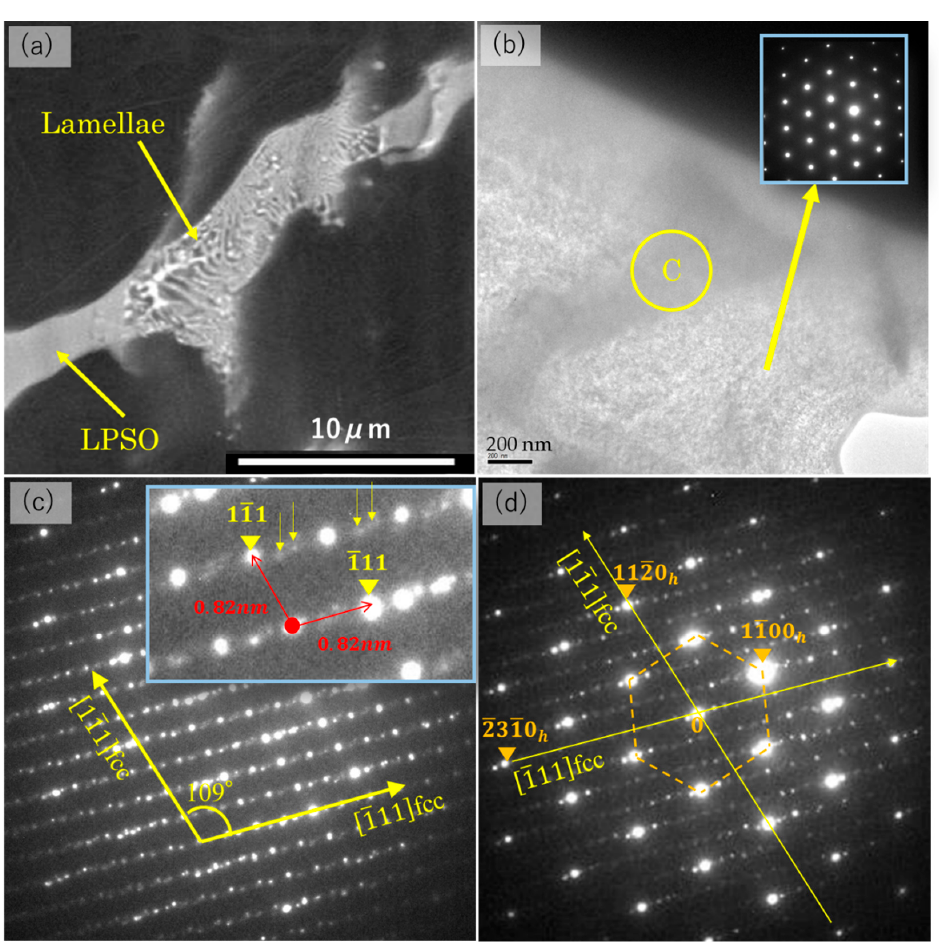
Figure 7. ( a ) Compositional image of BE mode of SEM for Mg 97 Zn 1 Y 2 alloy annealed at 643 K, which had been recovered after being annealed at 3 GPa and 823 K for 2 h. ( b ) Bright-field TEM image. The inset is the ED pattern of the bright phase indicated by an arrow. ( c ) The ED patterns of the locations of C in ( b ). An enlarged view of the ED pattern is shown as an inset. Refractions are assigned by the E phase, i.e., fcc with a lattice constant of 1.42 nm. ( d ) The ED patterns at the boundary between ( c ) and α -Mg. h means the index of hcp.